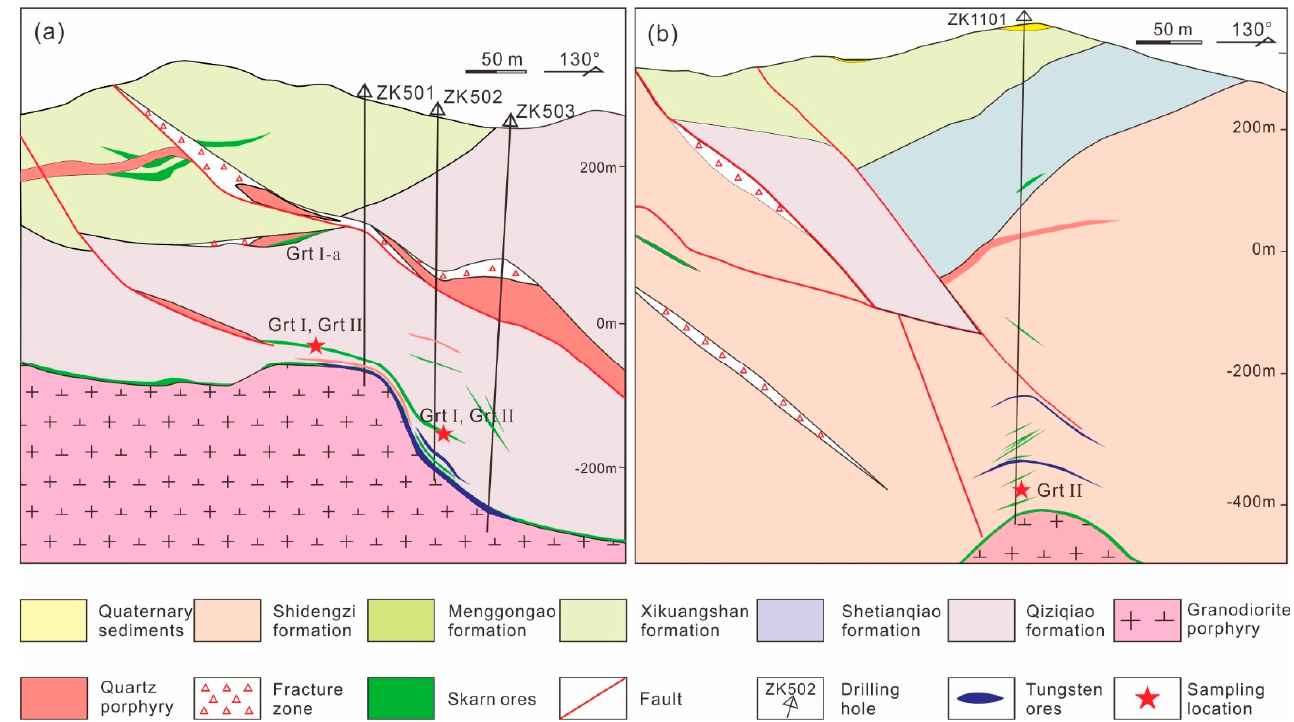
Figure 3. ( a ) No. 5 exploration line and sampling location of Tongshanling deposit; ( b ) No. 11 exploration line and sampling location of Tongshanling deposit.